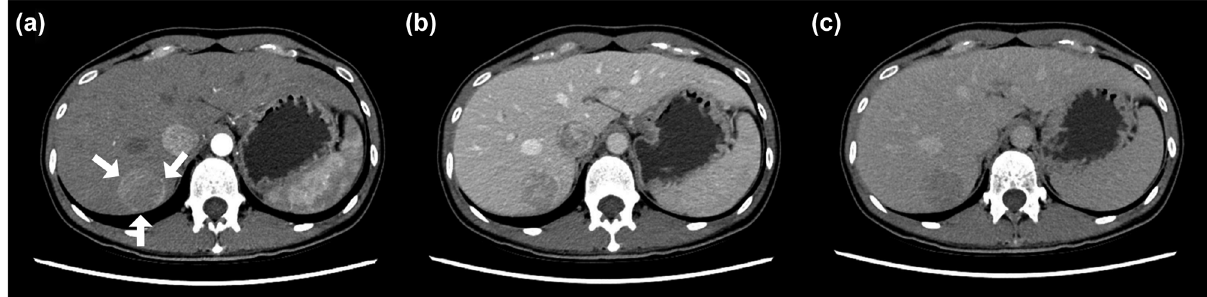
Figure 2: Contrast - enhanced computed tomographic ( CT ) imaging of a primary hepatic perivascular epithelioid cell tumor in the arterial ( a, 25 – 30 s ) , portal ( b, 60 s ) , and equilibrium ( c, 180 s ) phases. A heterogeneous enhancement can be seen during the arterial phase, while the contrast agent was washed out during the portal and equilibrium phases ( arrows )